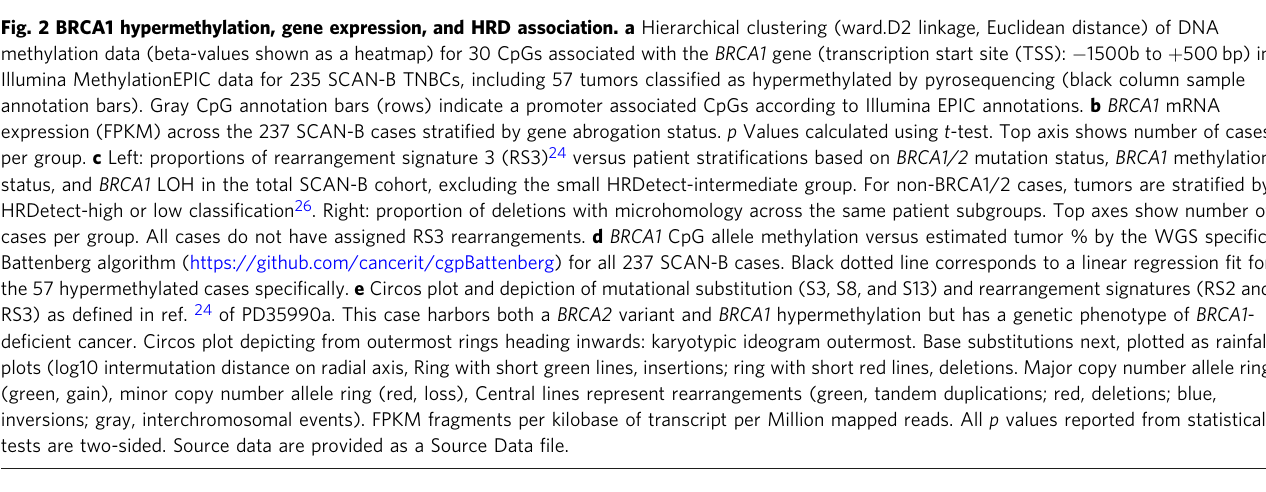
de fi cient cancer. Circos plot depicting from outermost rings heading inwards: karyotypic ideogram outermost. Base substitutions next, plotted as rainfall plots (log10 intermutation distance on radial axis, Ring with short green lines, insertions; ring with short red lines, deletions. Major copy number allele ring (green, gain), minor copy number allele ring (red, loss), Central lines represent rearrangements (green, tandem duplications; red, deletions; blue, inversions; gray, interchromosomal events). FPKM fragments per kilobase of transcript per Million mapped reads. All p values reported from statistical tests are two-sided. Source data are provided as a Source Data